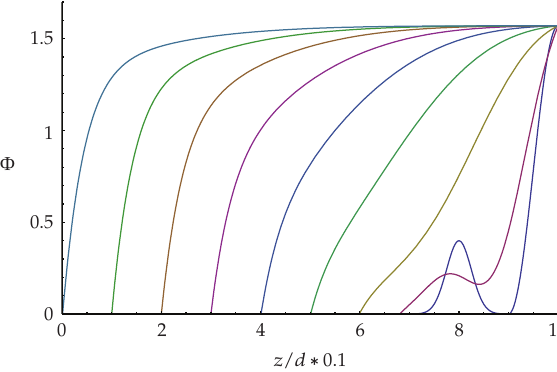
Figure 2: Propagation of the traveling wave with respect to the laboratory coordinate system (cid:3)(cid:2) z/d (cid:3) − vτ (cid:3) versus z/d ∗ 10 − 1 . Parameters of the method: J (cid:7) 7, Δ τ (cid:7) 0 . 005; parameters of Φ(cid:2)(cid:2) E/E cr the problem: q 1 (cid:7) 7 − vτ , q 2 (cid:7) 10, v (cid:7) 2, σ (cid:7) 0 . 25, E/E cr (cid:7)